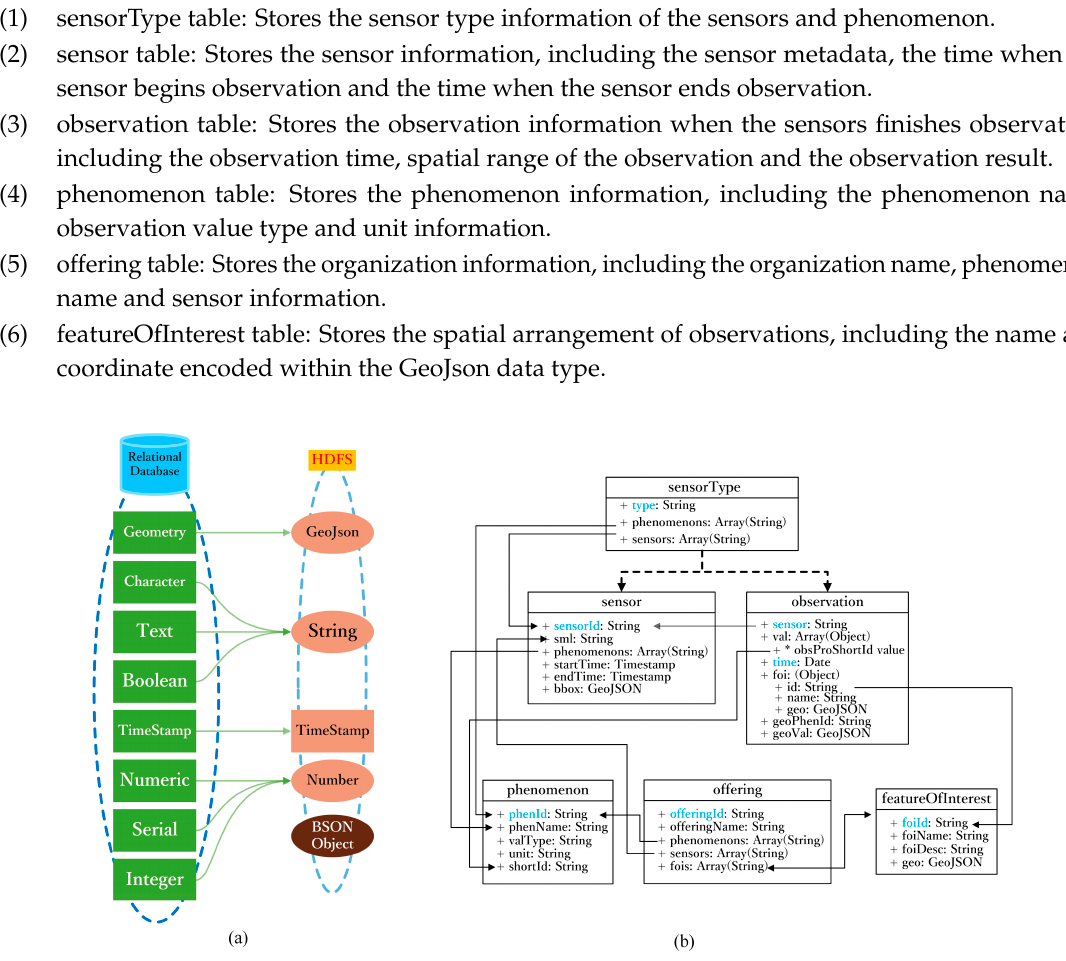
Figure 3. ( a ) The mapping of the data types from a relational database to the HDFS; ( b ) Tables design in HDFS for the SOS.